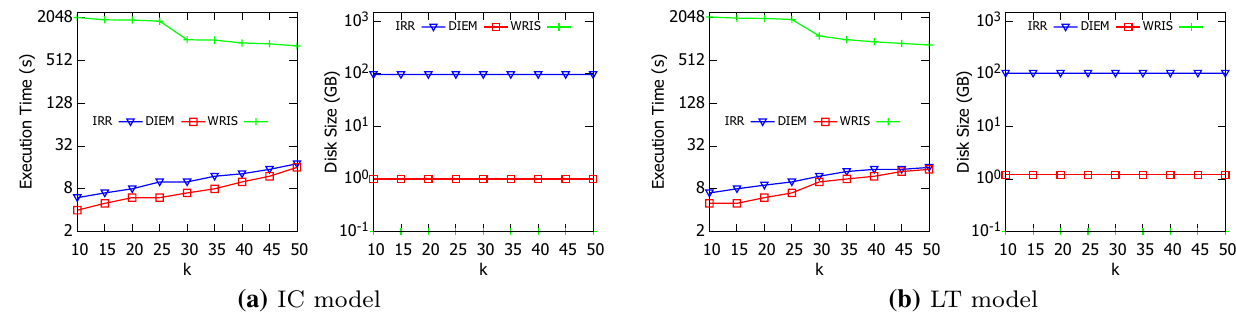
Fig. 1 Varying the seed set size: k